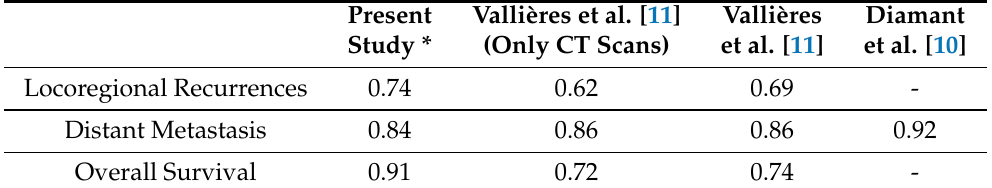
Table 4. Comparison of the performances of the predictive models of LRs, DMs, and OS developed in the present study and in the studies of Vallières et al. (only with information of CT scans and complete work) and Diamant et al. The results presented refer to the best AUC values obtained. The present study identified with an asterisk (*) presents a more reduced